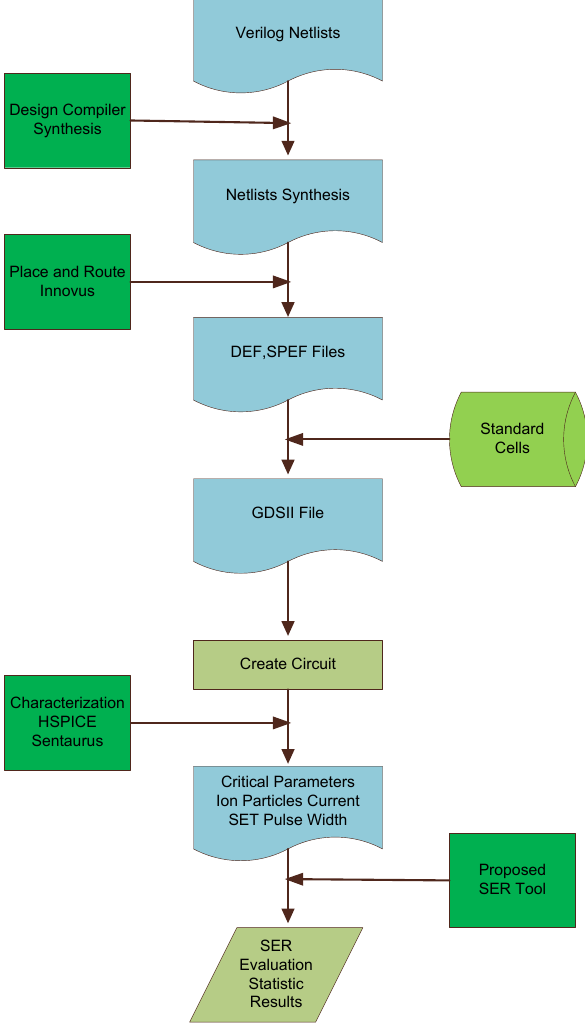
Figure 7. Overall SER simulation